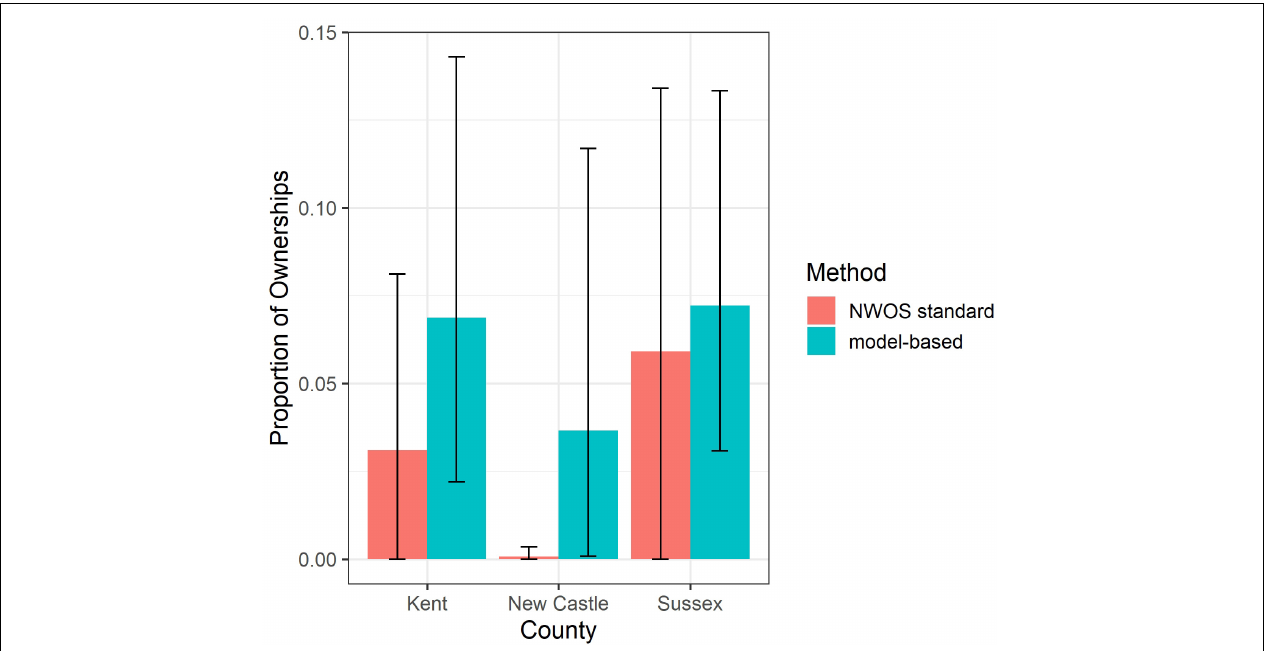
FIGURE 5 | Proportion of family forest ownerships (1+ ac) who have conducted commercial harvests in the past 5 years, by county. Delaware, United States, 2018–2020. Comparison of NWOS standard estimates and model-based estimates. Error bars are 95% confidence intervals for the NWOS estimates and 95% credible intervals for the model-based